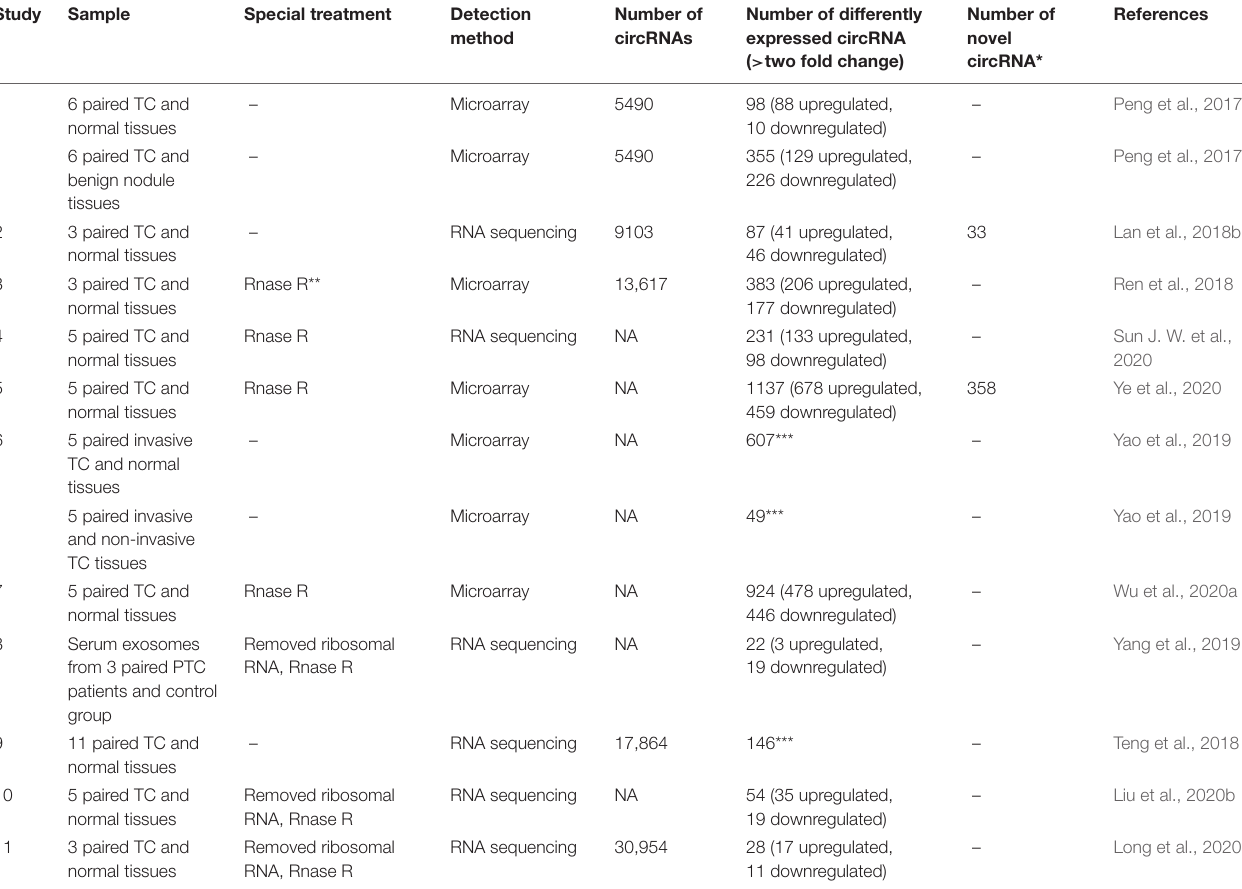
TABLE 1 | Overview of circRNAs identified by microarrays and RNA sequencing in